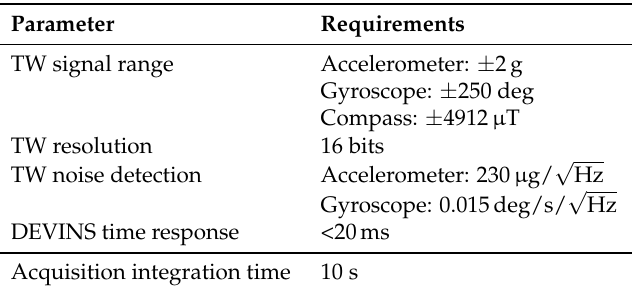
Table 7. TW sensor technical